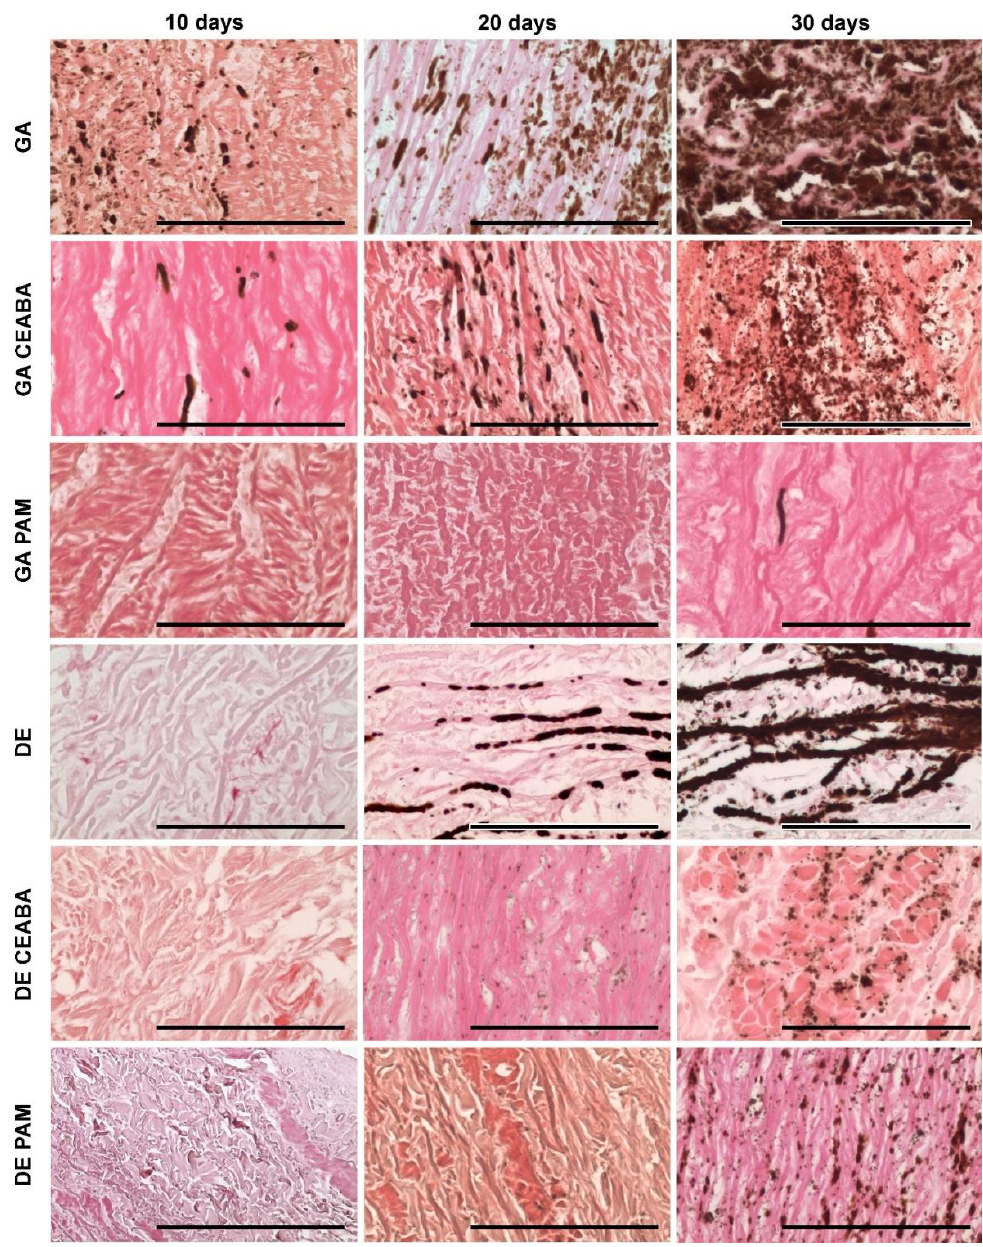
Figure 5. Calcium phosphate deposits in porcine aortic wall implanted subcutaneously in rats as visualized by von Kossa staining. Calcium phosphates are stained from light to dark brown and were localized predominantly along the elastin fibers or in smooth muscle cells. Scale bars: 100 μm.